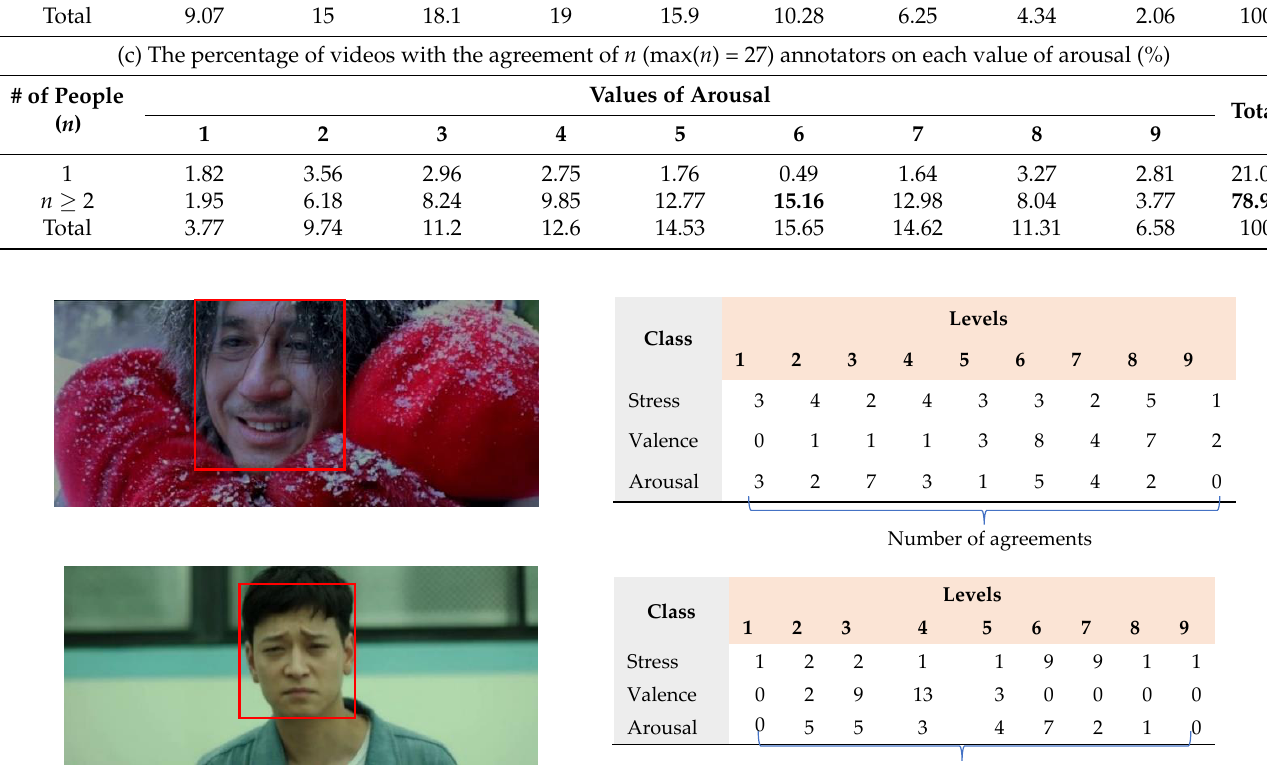
Figure 4. Examples of the number of agreements of people who annotated the given video with various stress levels, valence, and arousal. Table 3. The percentage of videos with the agreement of n (max(n) = 27) annotators on each value of stress, valence, and arousal.